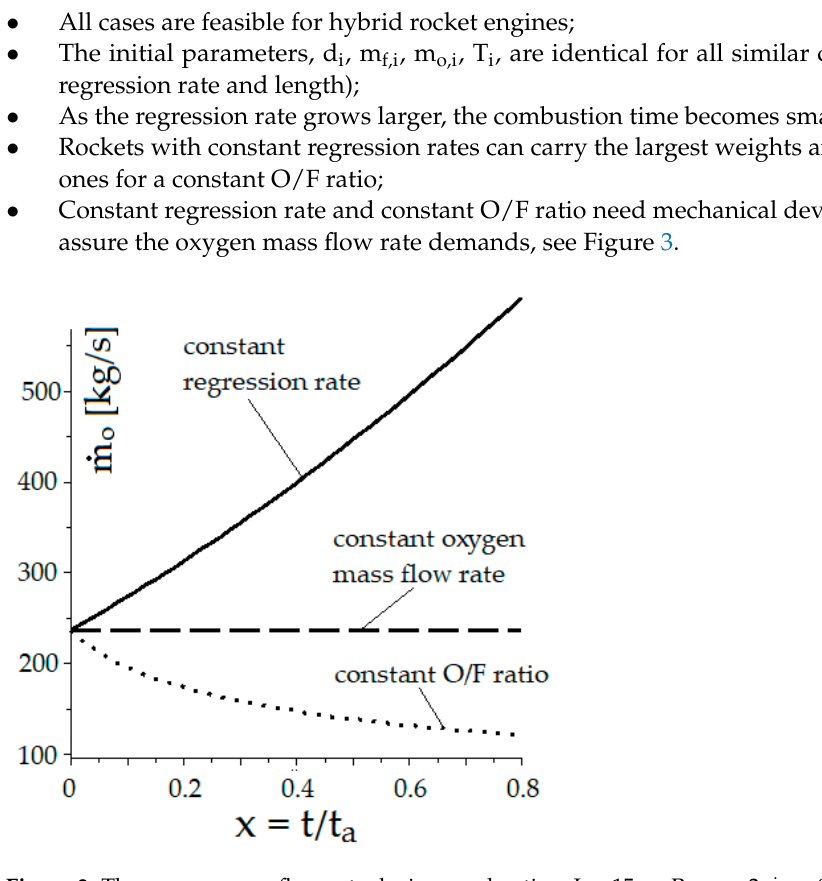
sm =  003.0r = 2, TM,i i